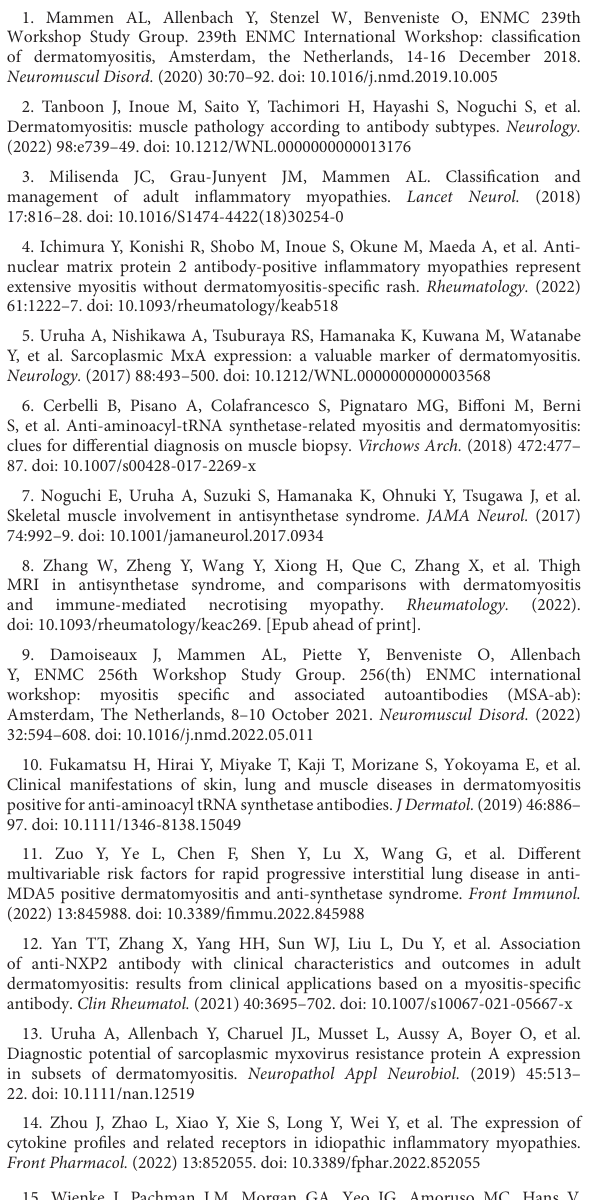
IL-1 receptor type 1; TIMP-1, tissue inhibitor of metalloproteinases-1. ∗ P < 0.05; ∗∗ P < 0.01; ∗∗∗ P < 0.001. SUPPLEMENTARYFIGURE2 Receiver operating characteristic curves of each cytokine/chemokine. (A) Receiver operating characteristic curves of serum CCL2. (B) Receiver operating characteristic curves of serum CCL4. (C) Receiver operating characteristic curves of serum TNFR2. (D) Receiver operating characteristic curves of serum CXCL13. (E) Receiver operating characteristic curves of serum IL-1ra. (F) Receiver operating